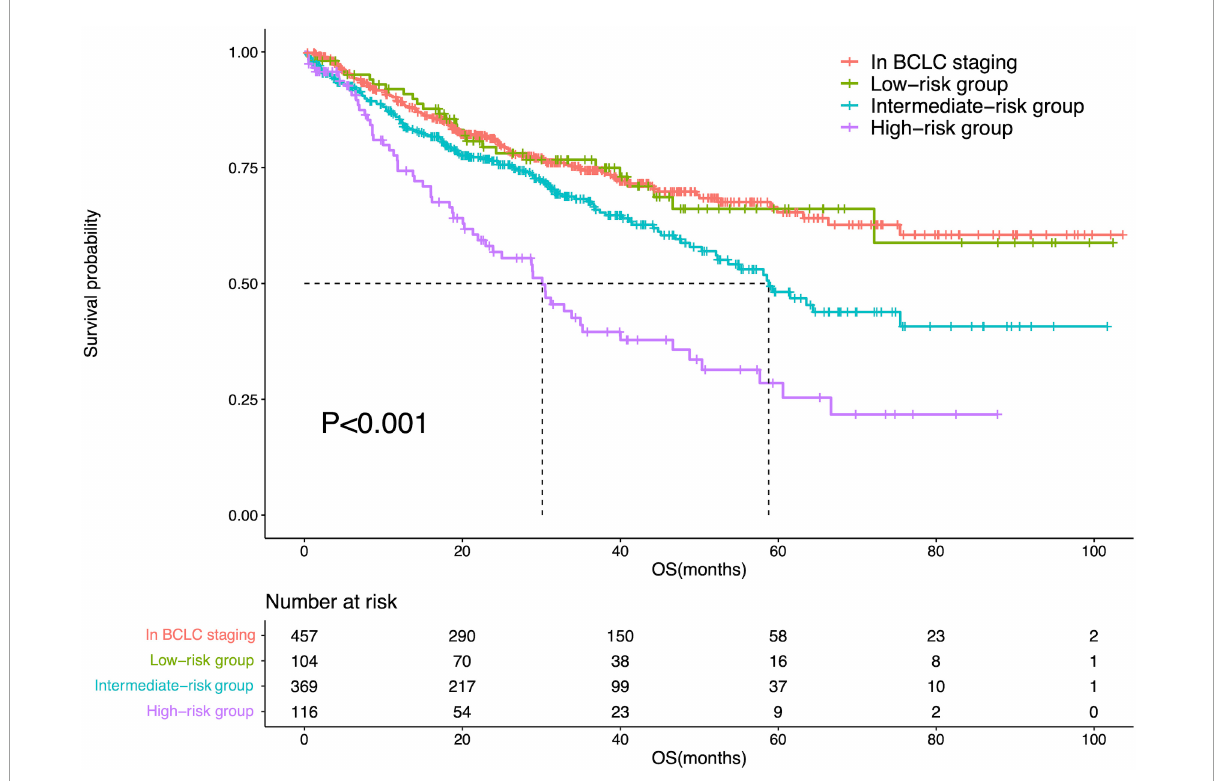
FIGURE6 Survival curves of the IPLRs in the BCLC staging system and those in the low-, intermediate-, and high-risk